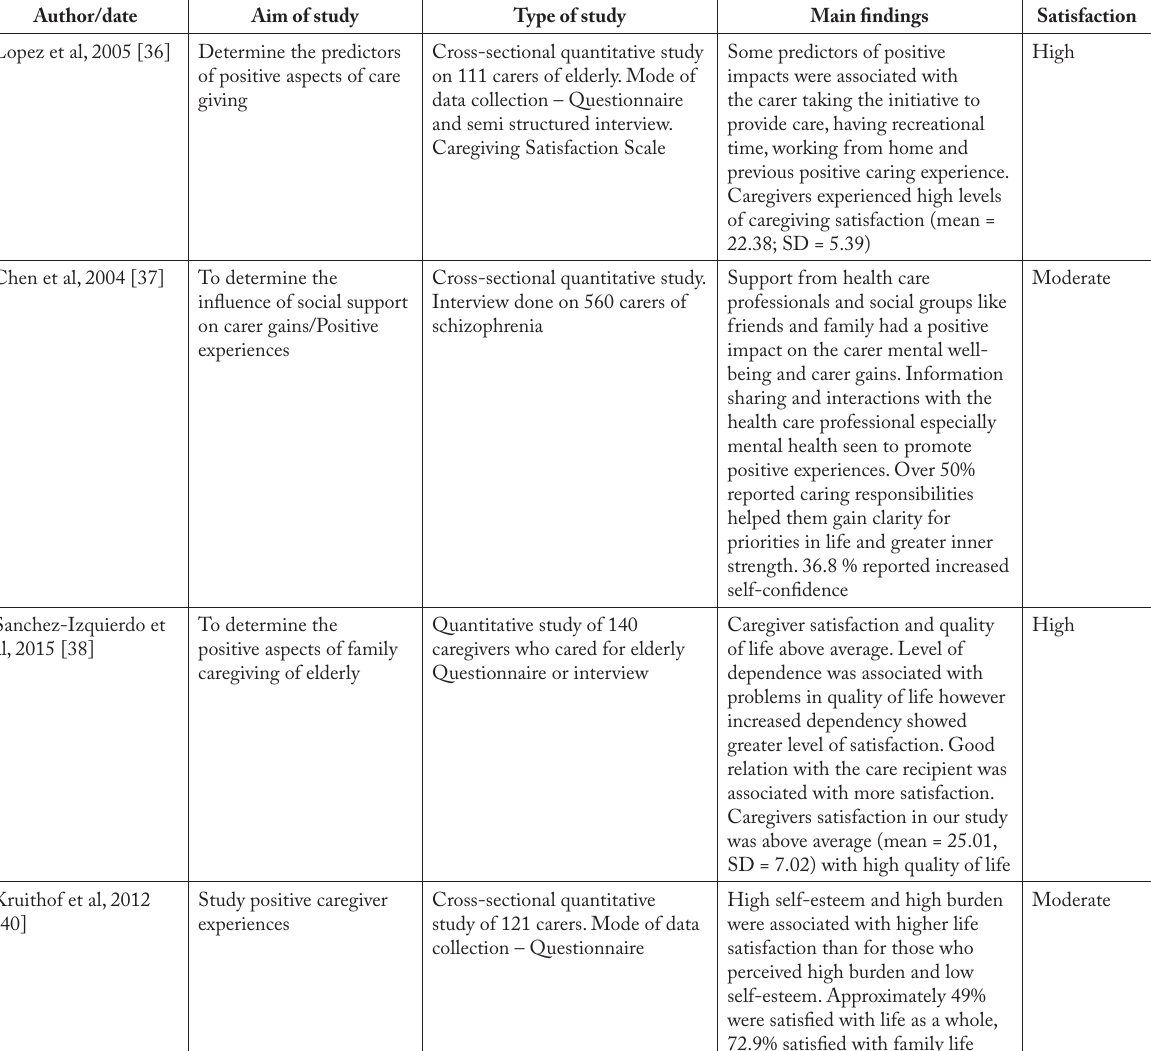
Table 7. Well-being and positive aspects among